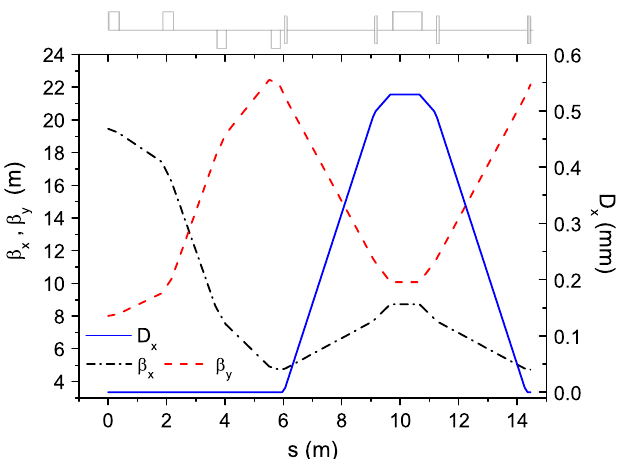
FIG. 4. (Color) Debunching properties of a first order achromatic bending system. Gaussian distributions for the longitudinal phase ¼ 0 : 4 nm and the bottom figures to (cid:3) space are assumed. The top figures refer to (cid:3) r . lengths refers to the indicated (cid:3) r